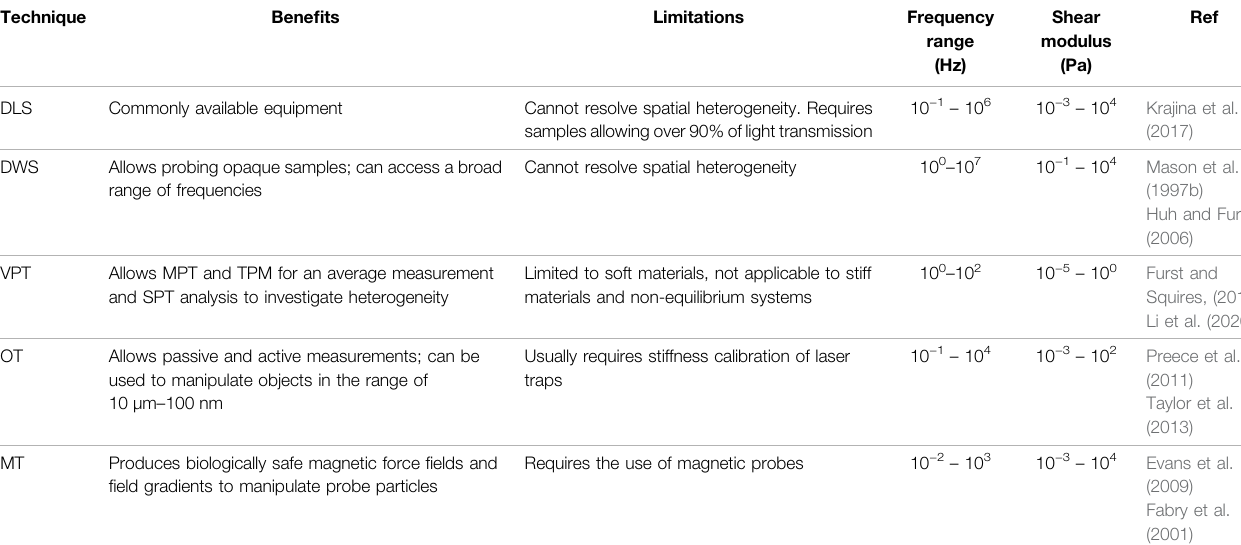
TABLE 1 | Summary of bene fi ts, limitations, and operating regimes of microrheological techniques, including dynamic light scattering (DLS), diffusing wave spectroscopy (DWS), video particle tracking (VPT), optical tweezers (OT), magnetic tweezers (MT). Technique Bene fi